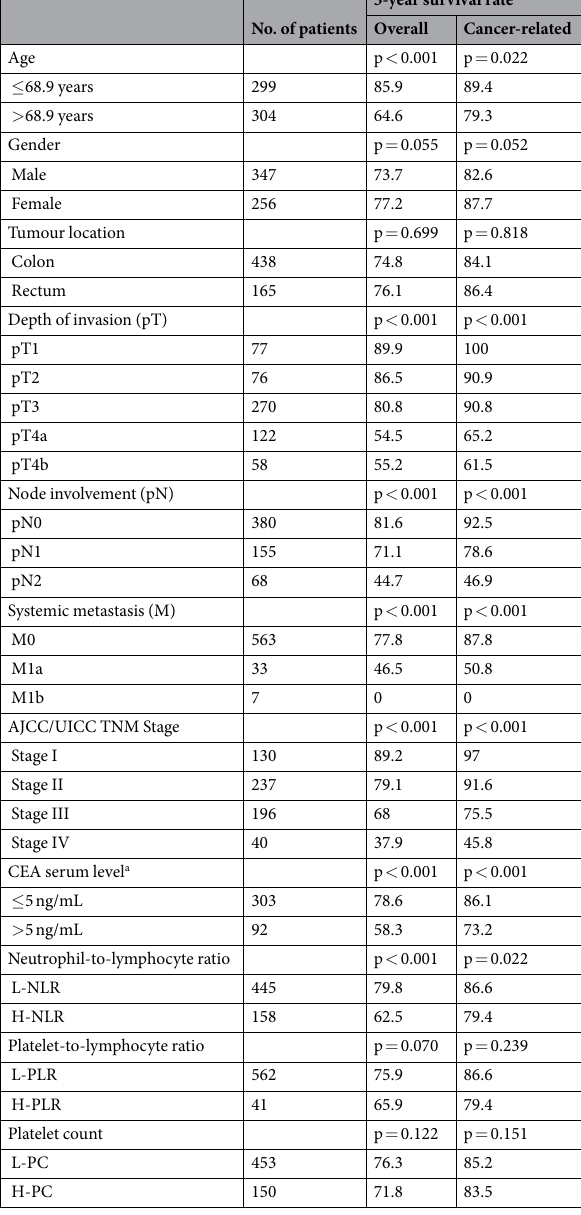
Table 3. Five-year overall and cancer-related survival rates according to the main clinicopathological characteristics, NLR, PLR and PC for the 603 patients under study. a CEA serum level was available for 401